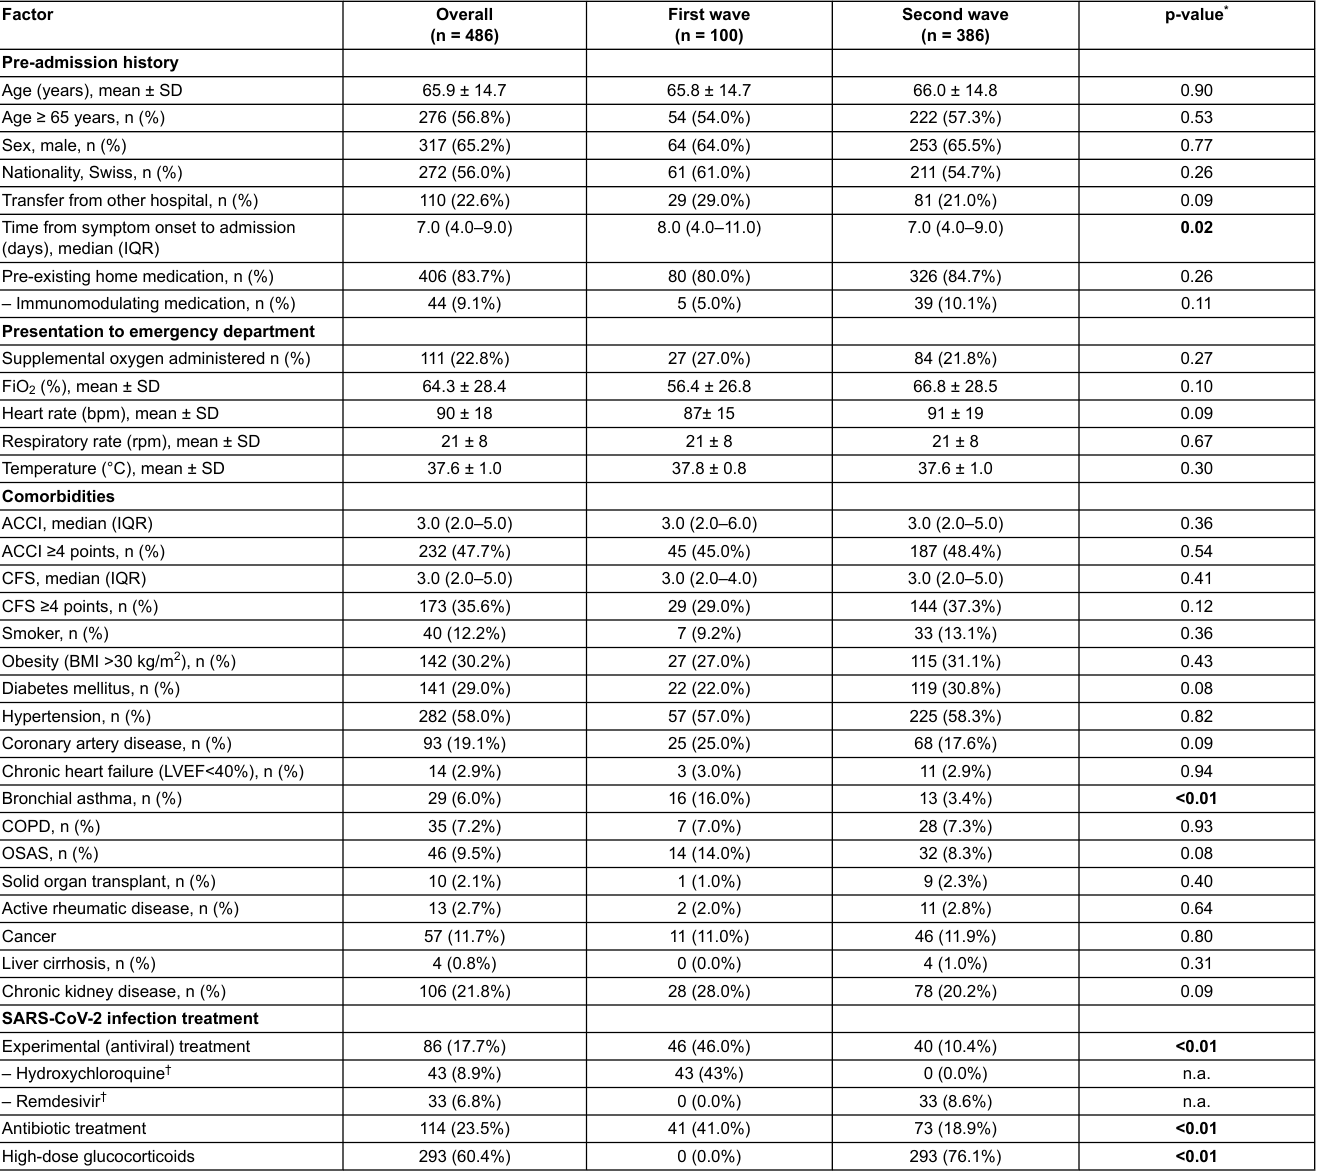
Table 1: Baseline characteristics and treatment of patients hospitalised with confirmed SARS-CoV-2